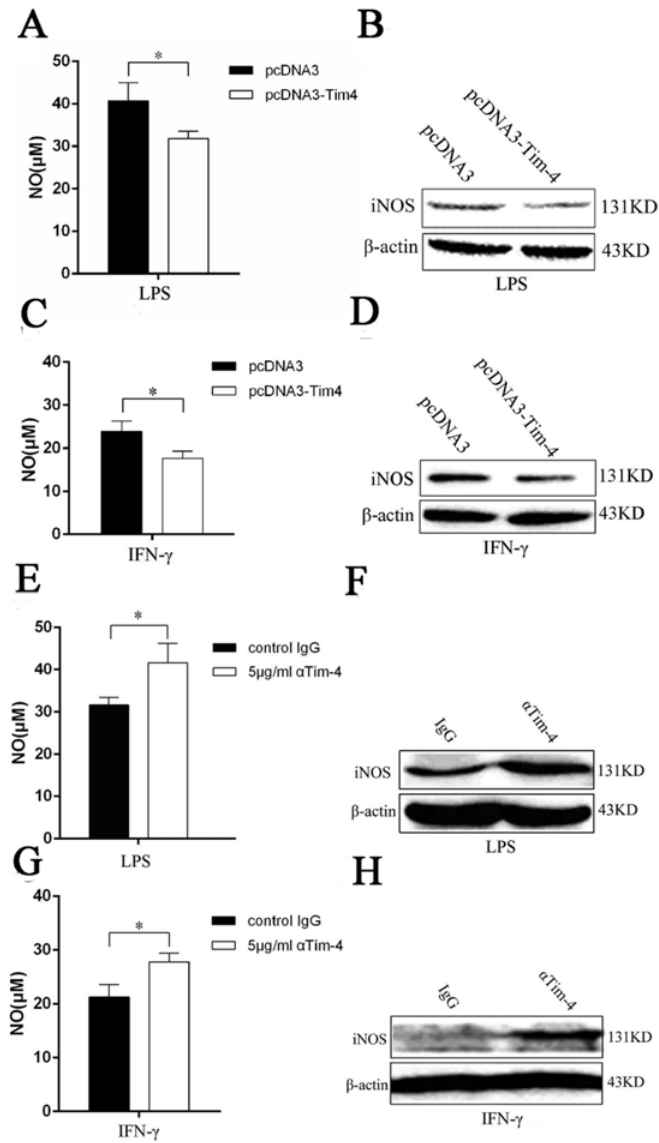
Fig 2. Tim-4 inhibited LPS/IFN- γ induced NO secretion and expression of iNOS protein. Tim-4 stably transfected cells RAW-pcDNA3-Tim-4 and control cells RAW-pcDNA3 were incubated with 100 ng/ml of LPS or 100 U/ml IFN- γ for indicated time. NO secretion in the supernatants was detected at 24 h after LPS or IFN- γ stimulation (A and C). iNOS expression was detected by western blot at 12 h after LPS (B) or IFN- γ treatment (D). Peritoneal macrophages were pre-treated with goat anti-mouse Tim-4 or control IgG at 5 μ g/ml for 1 h, and then stimulated with 100 ng/ml LPS or 100 U/ml IFN- γ for 24 h. Supernatants were harvested for NO analysis (E and G). iNOS expression was detected by western blot at 12 h after LPS (F) or IFN- γ treatment (H). In all panels, error bars represent the standard deviation from 4 independent cultures. A p value (student ’ s t- test) relative to the control cells of less than 0.05 is indicated by *